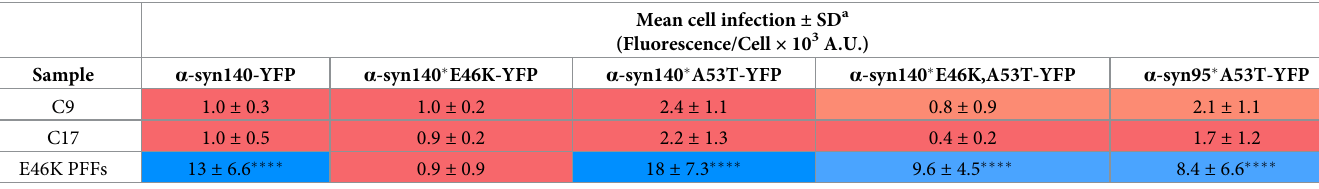
Table 4. Infectivity of TgM20 +/- passaged E46K PFFs in cultured cells.